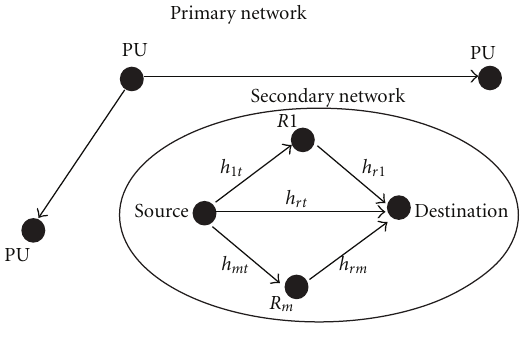
Figure 1: Primary and secondary